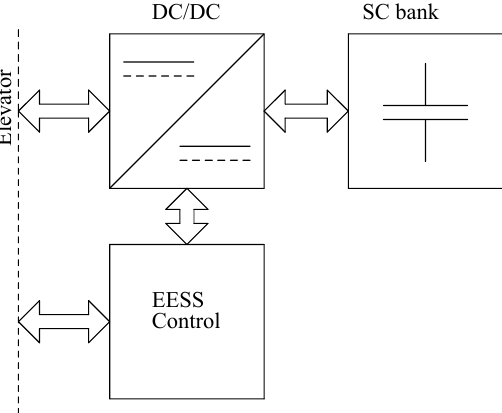
Figure 7. Schematic of supercapacitor-based